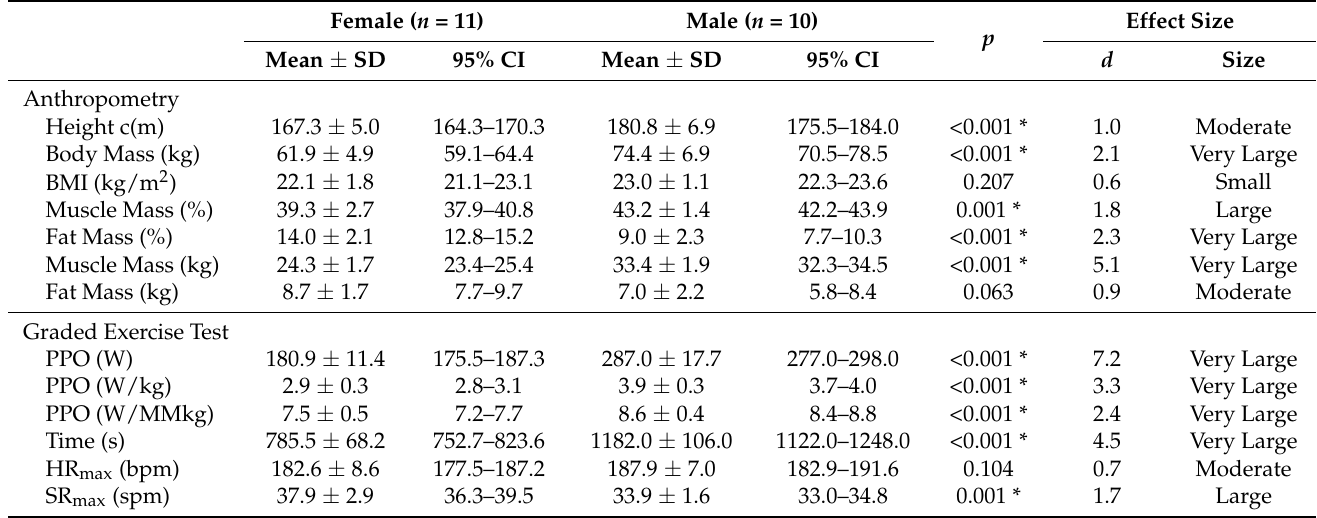
Table 1. Mean values of anthropometric characteristics and GXT parameters. Difference between female and male